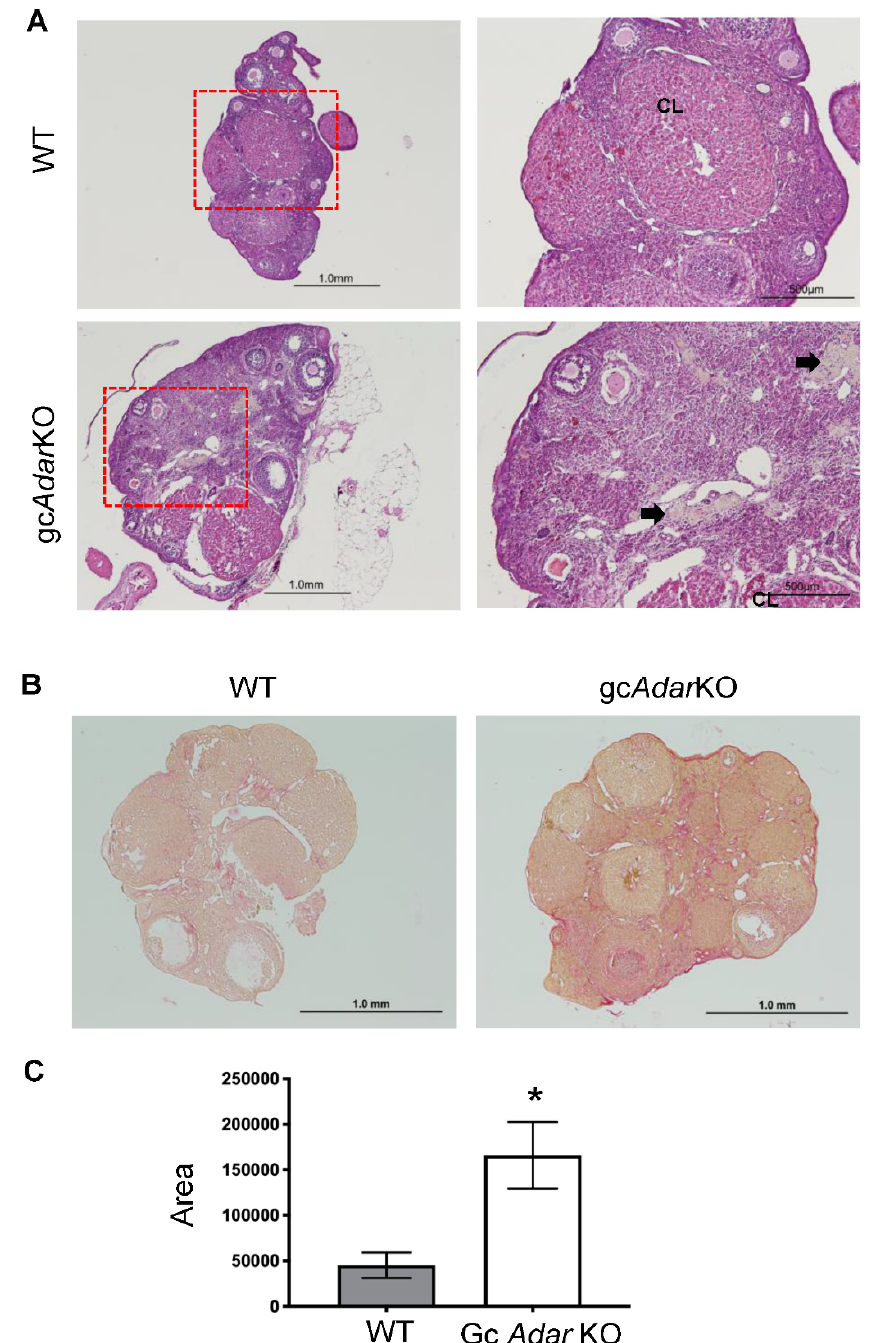
Figure 2. Histological analyses. ( A ) Histology analyses was performed in the ovaries from wild-type (WT) littermate control and gc Adar KO (n = 5) breeding trial mice (n = 6). Sections from the middle region of tissue were selected for H&E staining. Control ovaries display corpora lutea (CL) and follicles of varying size. Ovaries from gc Adar KO mice display fewer corpora lutea and similar follicle sizes. Yellow-multinucleated (arrows) cells can be seen in all gc Adar KO ovaries. ( B ) Picrosirius red staining was completed in the ovaries of WT and gc Adar KO mice. ( C ) Wild-type mice (n = 3) exhibited red staining intensity of 45,133 ± 14,019 pixels/µm 2 , while gc Adar KO mice (n = 4) had increased ( p = 0.04) intensity at 166,005 ± 36,643 pixels/µm 2 . * Denotes significant ( p <0.05) difference between means ± SEM.